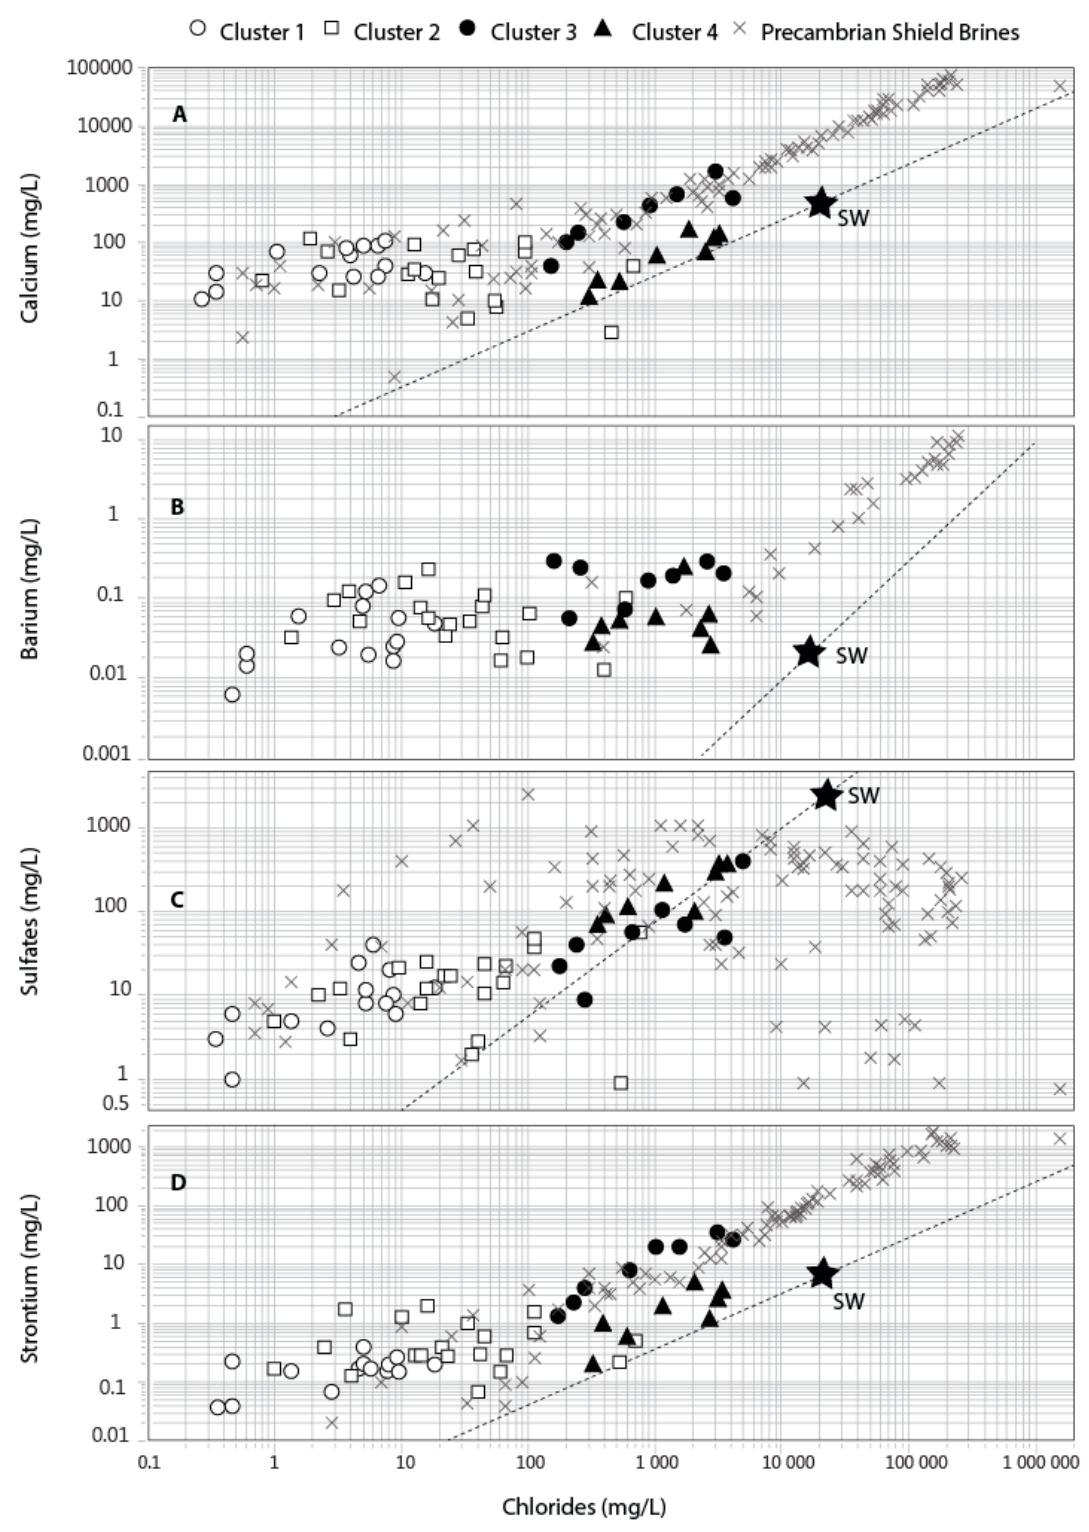
Figure 12. Log-log plots of Ca 2+ vs. Cl − concentrations in mg/L ( A ). Ba 2+ vs. Cl − concentrations in mg/L ( B ). SO 42 − vs. Cl concentrations in mg/L ( C ), and Sr 2+ vs. Cl − concentrations in mg/L ( D ). Seawater (SW) dilution lines were defined using seawater ratios from Goldberg [42]. The strong linear correlation between calcium, strontium, and chloride in PSB groundwater suggests a mass ratio Ca 2+ /Sr 2+ ≈ 40 for salinization related to basement fluids.